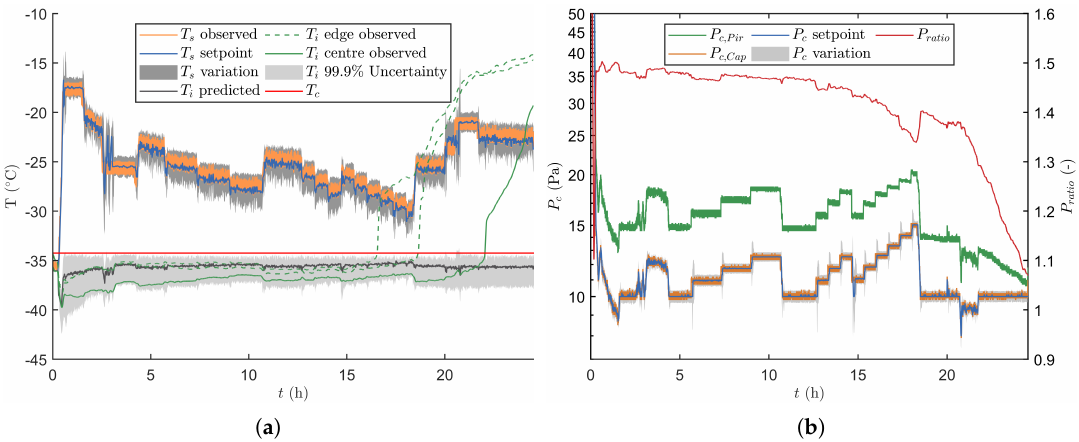
Figure 8. Third verification run with several intended P c and T s disturbances. ( a ) Depiction of T s together with its associated variation, and T i . The latter variable was either estimated by the primary drying model, or experimental measured for both the edge and centre vials. ( b ) The different P c signals are plotted in time together with its regularly updated